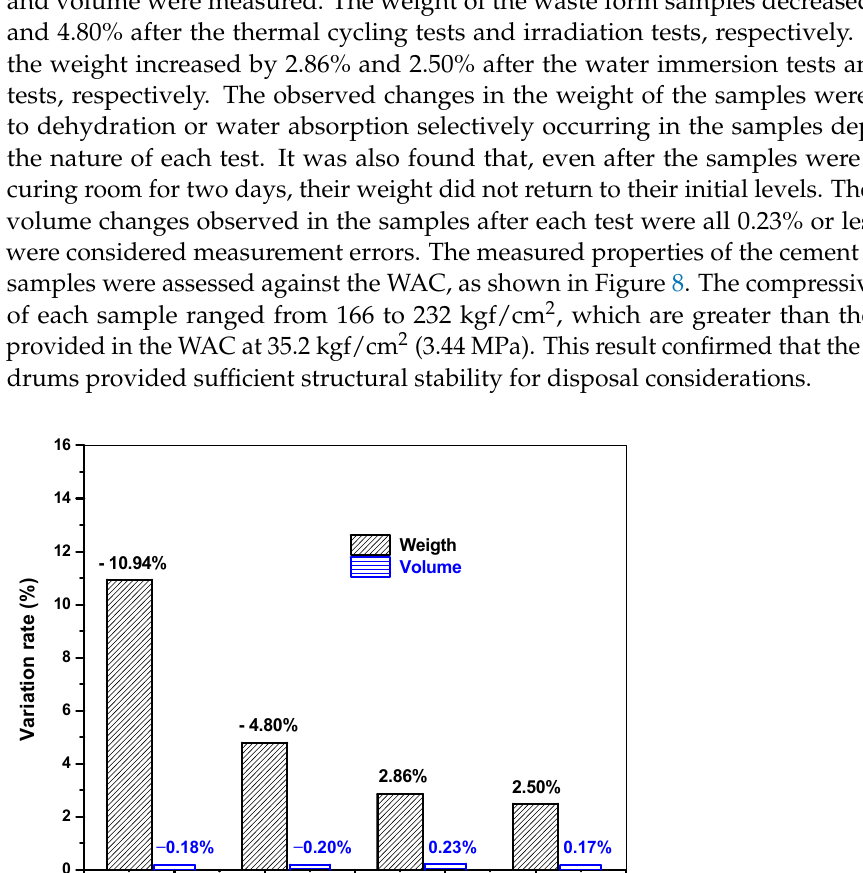
Figure 8. Comparison of compressive strengths of the representative samples of waste-form drums after each test (0.35 of w/c and 11 wt.% of spent resin). 3.2. Leaching Safety of Waste Forms The respective CFLs of each nuclide (Cs, Sr, and Co) are presented in Table 10. Figure 9 presents changes in the CFL of Cs over time (day) measured in the cement waste form samples. It was found that the leaching of Cs occurred at a rapid pace for the first five